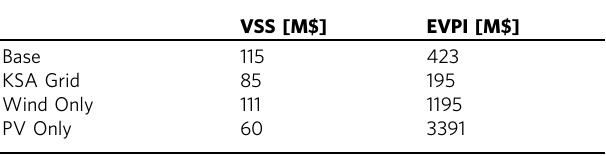
Table 5 Value of Stochastic Solution (VSS) and Expected Value of Information